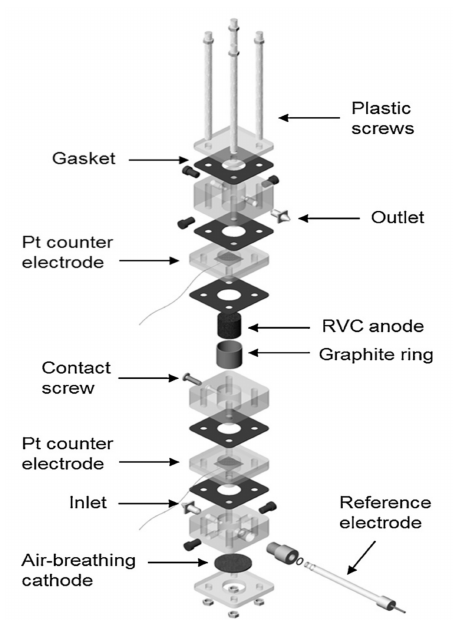
Figure 12. Schematic view of the EFC reported in